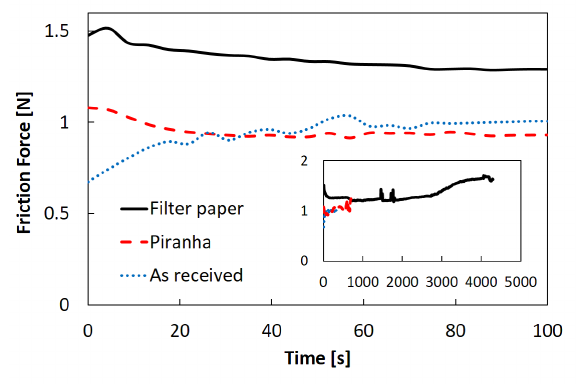
Figure 2. Time evolutions of friction forces for three samples of different adhesion strengths with bottom glass slide: Filter paper (solid line), Piranha (dashed line), and As received (dotted line). Main figure and inset correspond to the time evolutions of the initial 100 s and those until entire rupture of the samples, respectively. The fatigue lives were 4304 ± 56, 1457 ± 535, and 535 ± 288 s for Filter paper, Piranha, and As received samples, respectively. F N = 4.41 N for all samples.